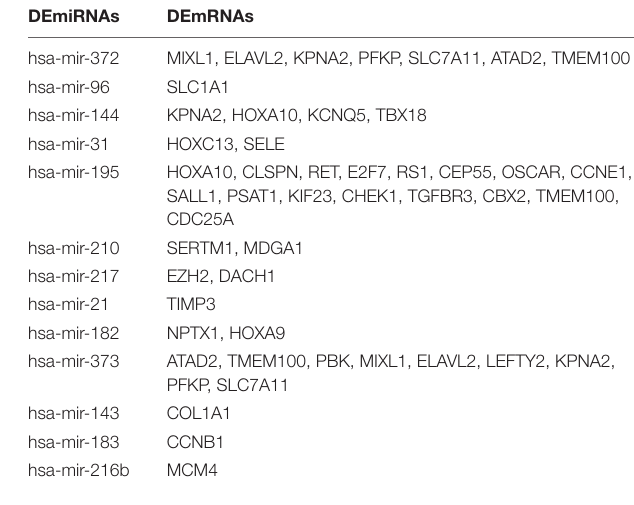
TABLE 3 | The 13 DEmiRNAs with their target DEmRNAs in the ceRNA